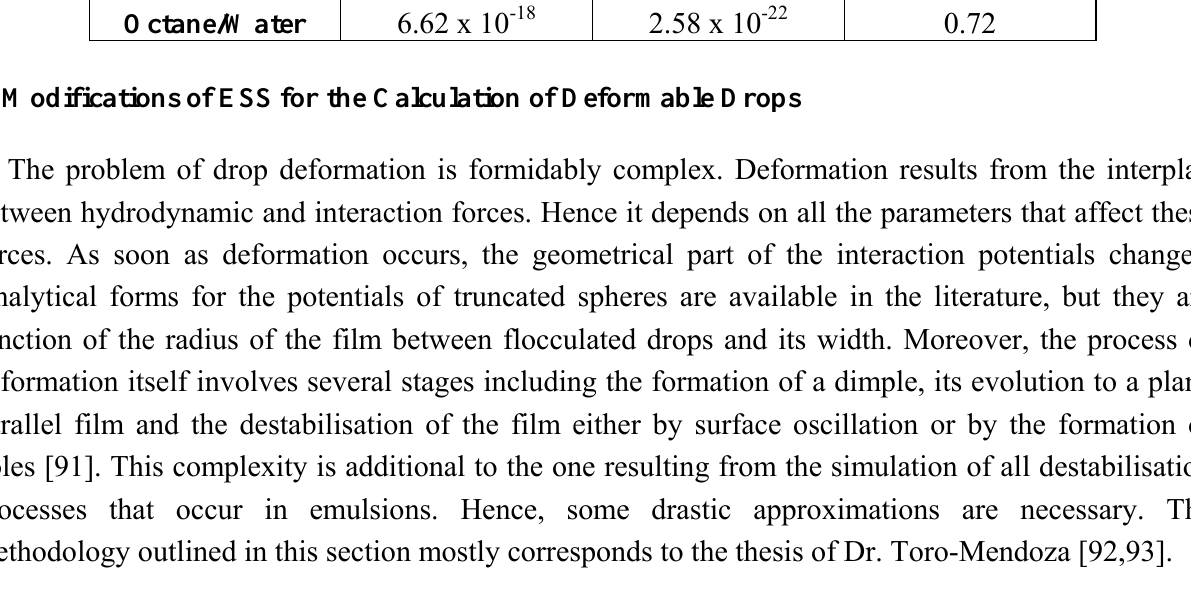
= 2.01 x 10 18 m -3 0